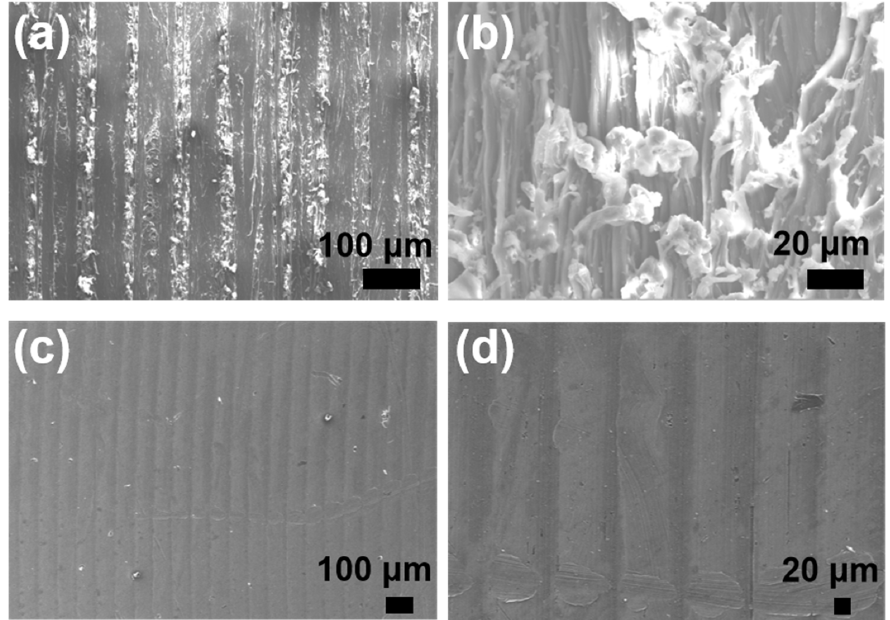
Figure 9. SEM images of surface morphologies after impact tests for the three hydrated Caprinae horn sheaths: ( a , b ) Cg ‐ hs; ( c , d ) Wg ‐ hs.